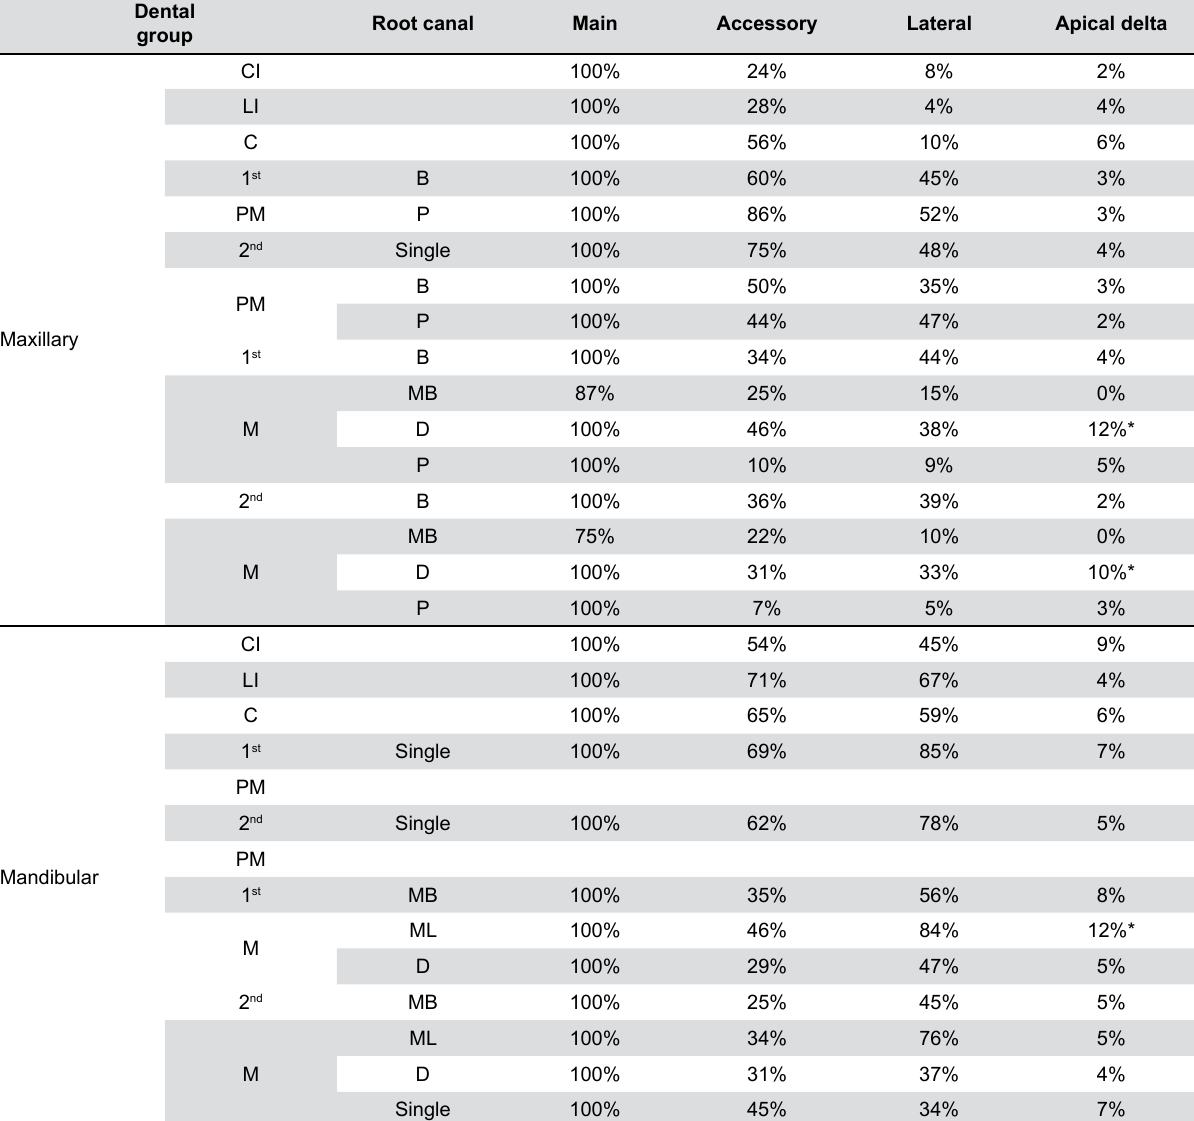
Table 2- Percentage distribution of root canal types found according to the AAE (2017)